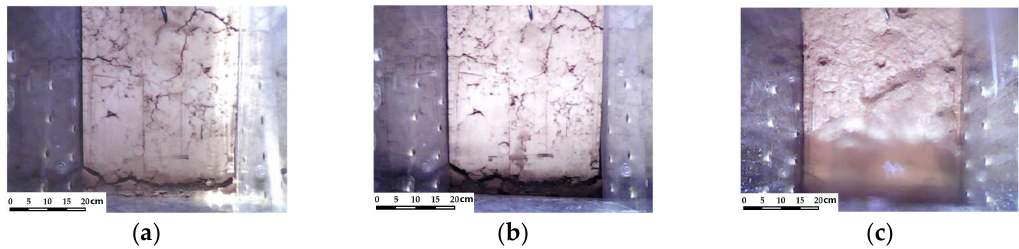
Figure 9. Photos of cracks on the 1:3 slope during the dry period of the test. ( a ) Cracks on day 7 of the dry period; ( b ) Cracks with little development on day 19 of the dry period; ( c ) Cracks healing during the second rainfall.